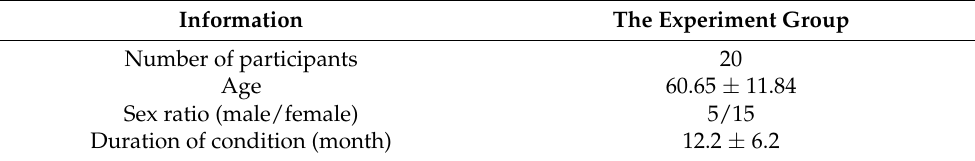
Table 1. Demographic information of the experiment participants.